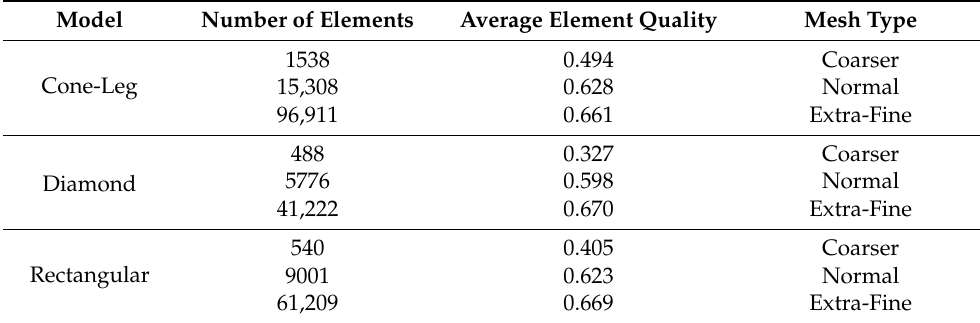
Table 3. Summary of the mesh types under consideration: TEG geometry, number of elements and mesh